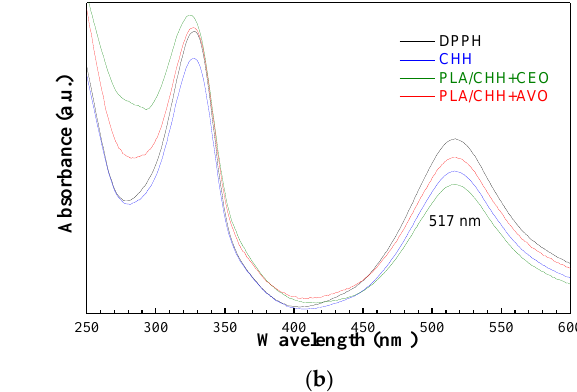
Figure 5. Water contact angle of PLA film with oil-loaded chitosan coatings. The data are expressed as mean ± standard deviations from triplicate determinations. a–c Mean values with different letters indicate significant differences at p < 0.05.